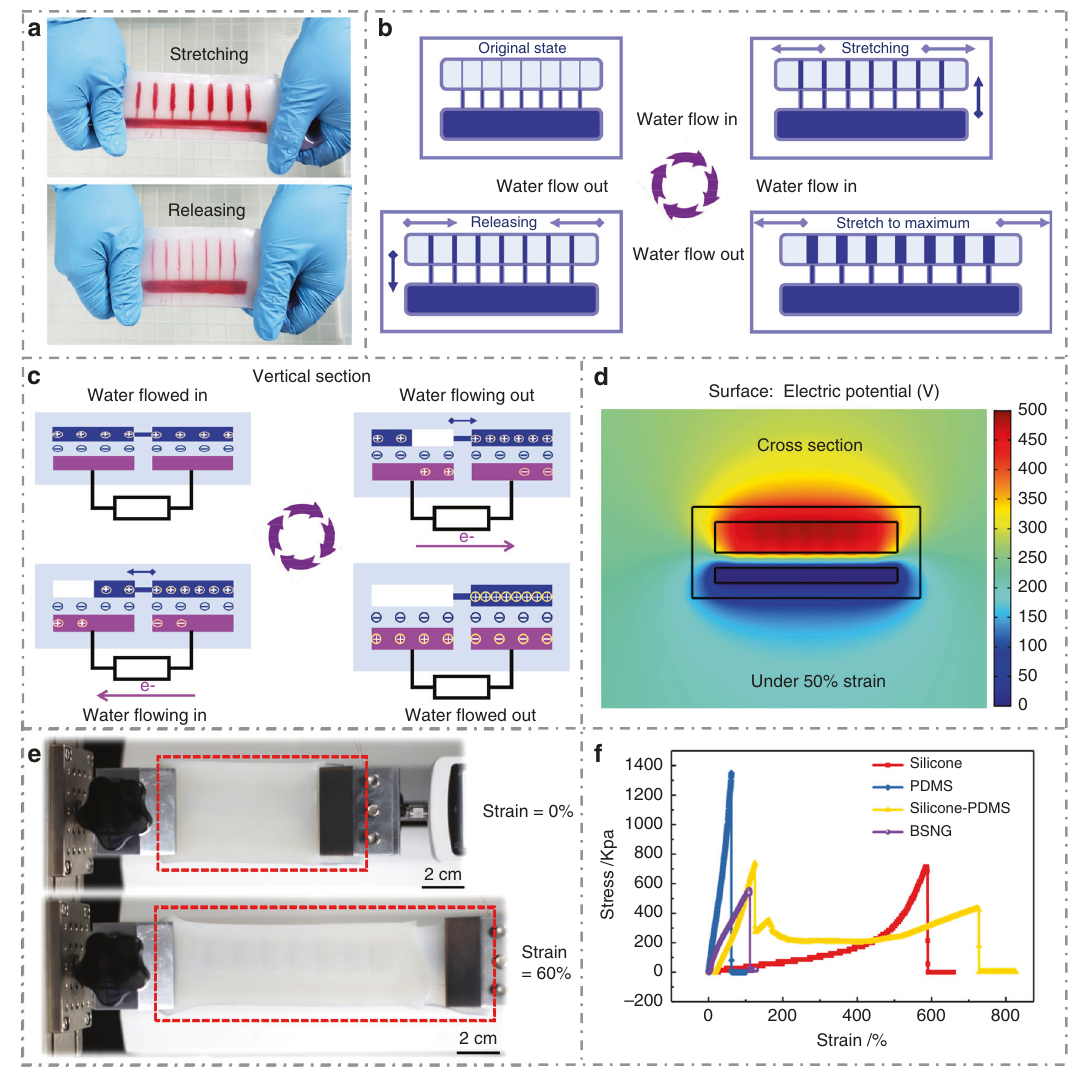
Fig. 2 Working principle and stretchability of bionic stretchable nanogenerator. a Photographs of one working cycle of bionic stretchable nanogenerator (BSNG) (red ink fi lled in). b Schematic diagram of the working process of BSNG. c Schematic diagram of the working mechanism of BSNG. d Simulation result of BSNG under 50% strain. e BSNG (indicated by red frame) at initial state (0% strain) and stretched state (60% strain). f Uniaxial tensile test of the silicone, polydimethylsiloxane (PDMS), silicone-PDMS and